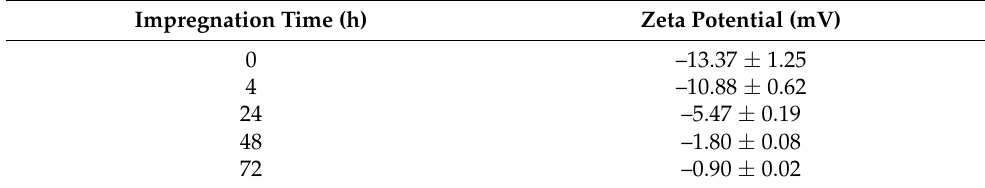
Table 1. Effect of ethanol impregnation duration time on zeta potential of i -Pd(OAc) 2 (TPPTS) 2 .